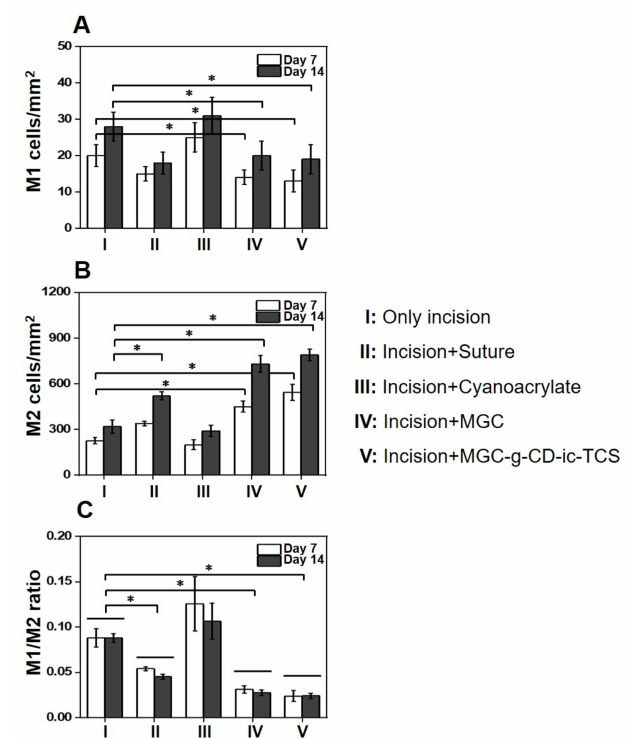
Figure 10. ( A ) M1, ( B ) M2, and ( C ) M1/M2 ratio of untreated incision, and incisions treated with suture (incision + suture), cyanoacrylate (incision + adhesive), MGC (incision + MGC), and MGC-g- CD-ic-TCS (incision + MGC-g-CD-ic-TCS) after 7 and 14 days ( n = 3, * p <